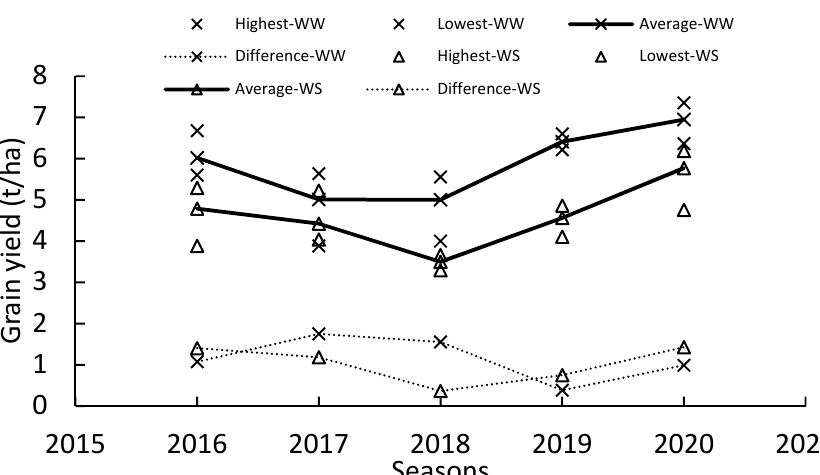
Figure 1. The changes in the highest and the lowest yield among the foxtail millet varieties each season and the average yield of the varieties under well-watered and water-stressed treatments for the five growing seasons (the Difference was defined as the difference between the varieties with the highest and lowest yield).